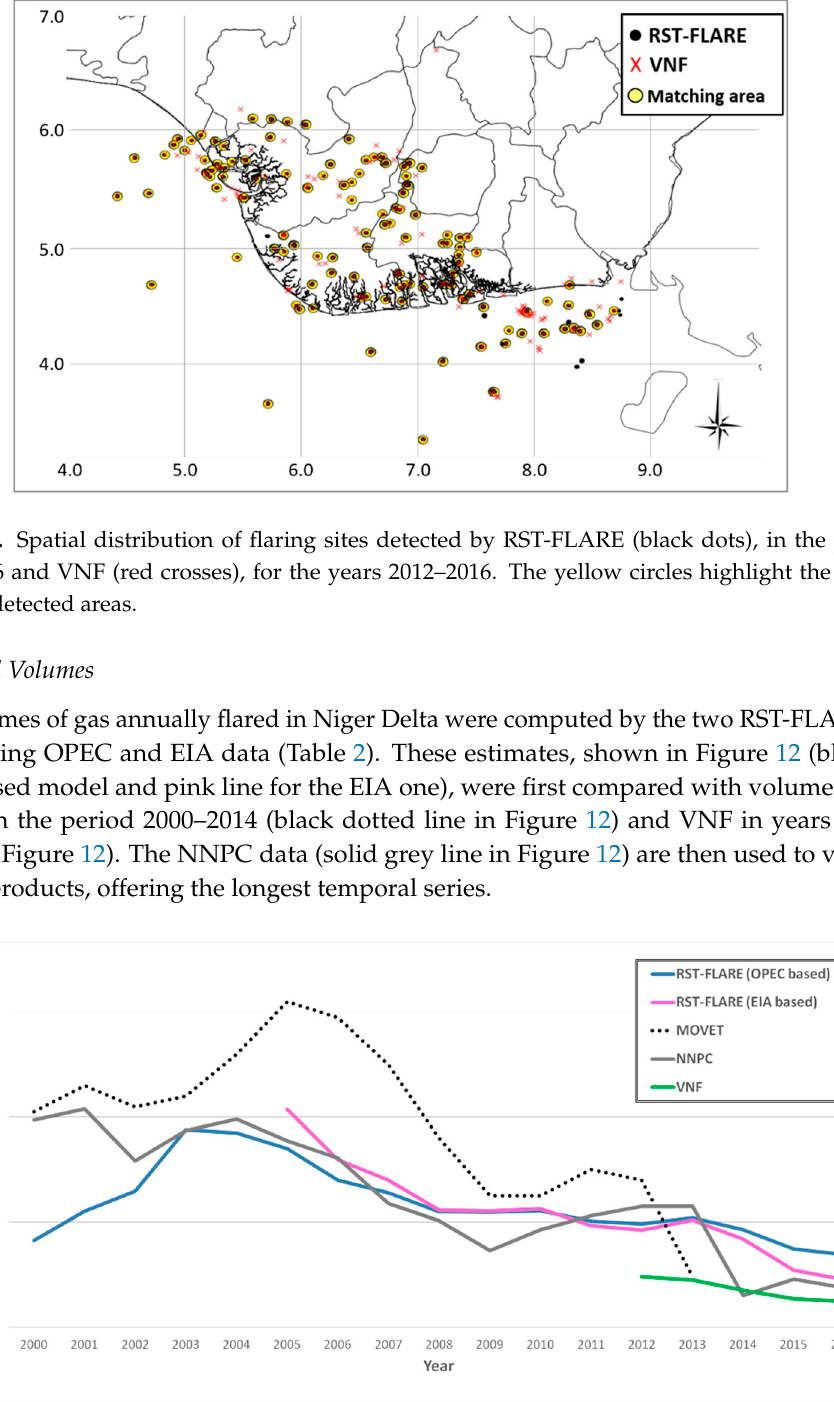
Figure 12. Annual gas flared volumes computed for the Niger Delta region by RST-FLARE, based on OPEC (blue line) and EIA (pink line) sources. MOVET, adapted from [12] and VNF estimates (black dotted line and green line, respectively) are also shown. The solid grey line refers to the data independently provided by NNPC.